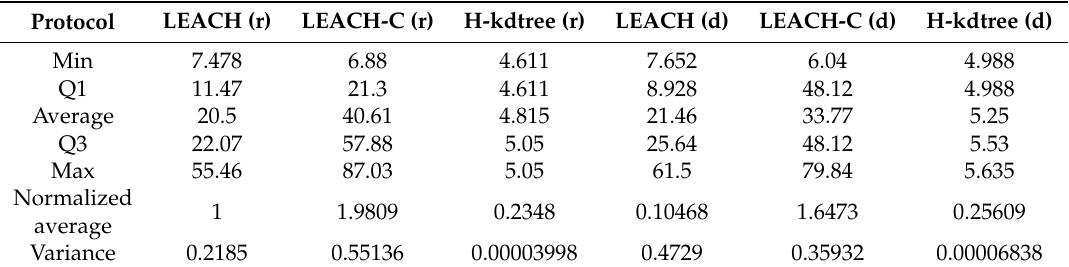
Table 7. Jitter with 200 nodes. (r) random—(d) deterministic. The values of the table are on a scale of 10 − 3 .